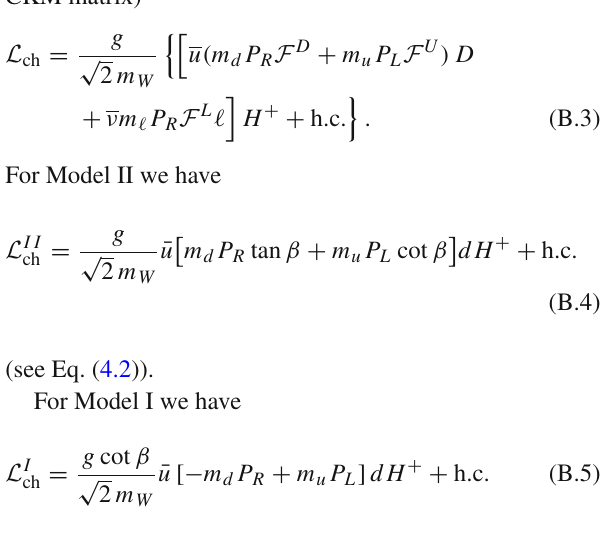
Table 7 Dictionary of notations. “HHG”: Higgs Hunter’s Guide [6]. “BHP”: Barger, Hewett, Phillips [296]. “G”: Grossman [191], “AS”: Akeroyd, Stirling [15]. The (*) denotes interchange (cid:4) 1 ↔ (cid:4) 2 . “ARS”: